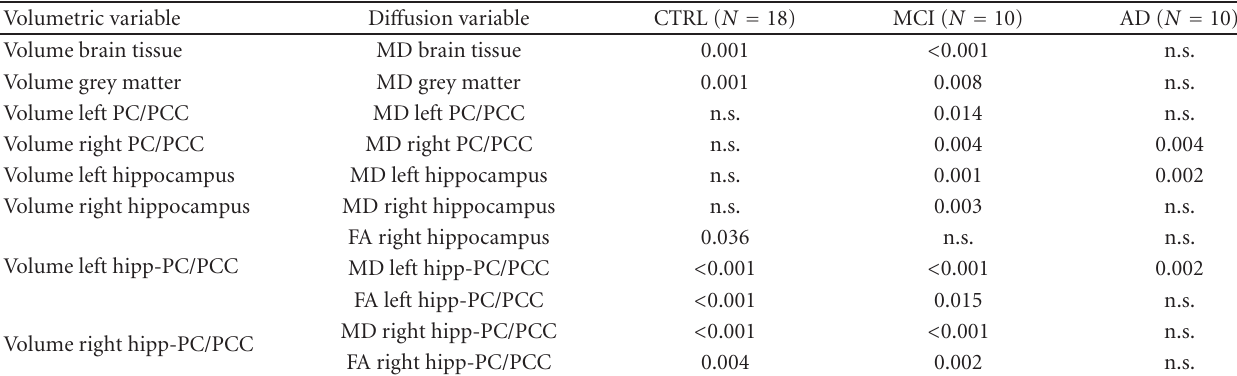
Table 5: Pearson’s correlation between volumetric and di ff usion MR indexes.